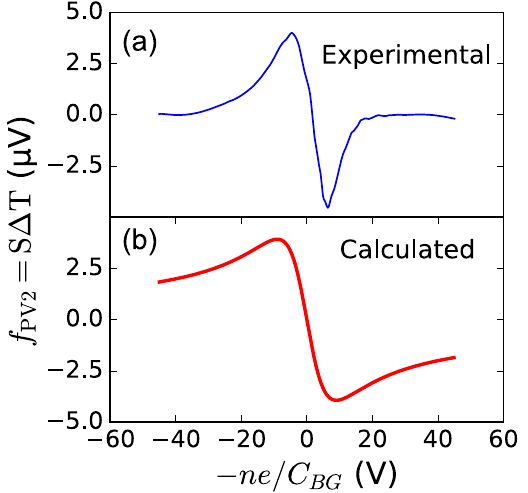
Figure 5. A comparison of the product of the Seebeck coefficient and temperature increase obtained experimentally and calculated theoretically as a function of the carrier density. (a) The experimental curve has been obtained by Fourier transforming the data in Fig. 3(a) and represents the function f PV 2 , which corresponds to the region exposed to the top gate. (b) The theoretical curve has been calculated by calculating the Seebeck coefficient using the Mott relation and with a temperature increase of 50 mK.